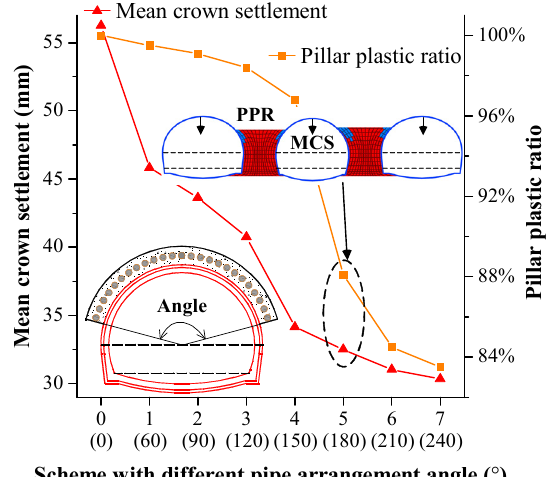
Figure 12. Effect of pipe arrangement angle on MCS and PPR. Figure 12. E ff ect of pipe arrangement angle on MCS and PPR.